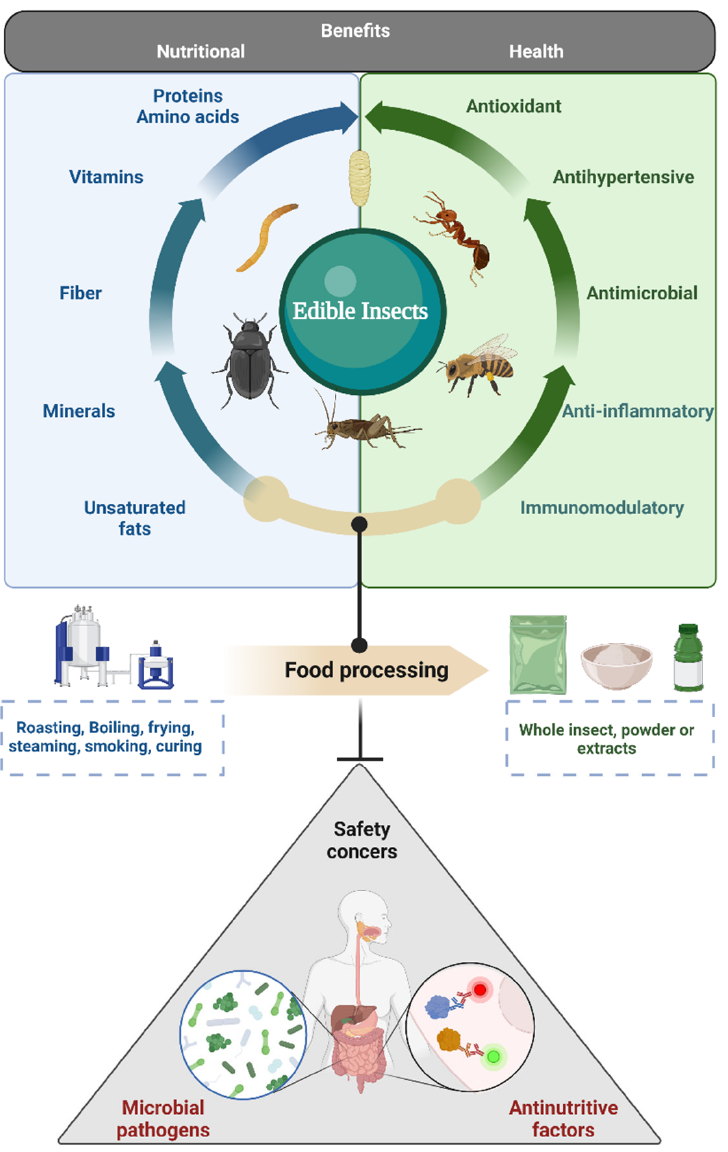
Figure 1. Nutritional and health benefits associated with edible insects. Food processing contributes to the safety of insects for human consumption by targeting safety concerns such as microbial pathogens and anti-nutritive factors. Created with Biorender.com